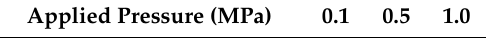
Table 1. Activation energies on the oxidation reactions of mesophase pitch under various applied pressures.